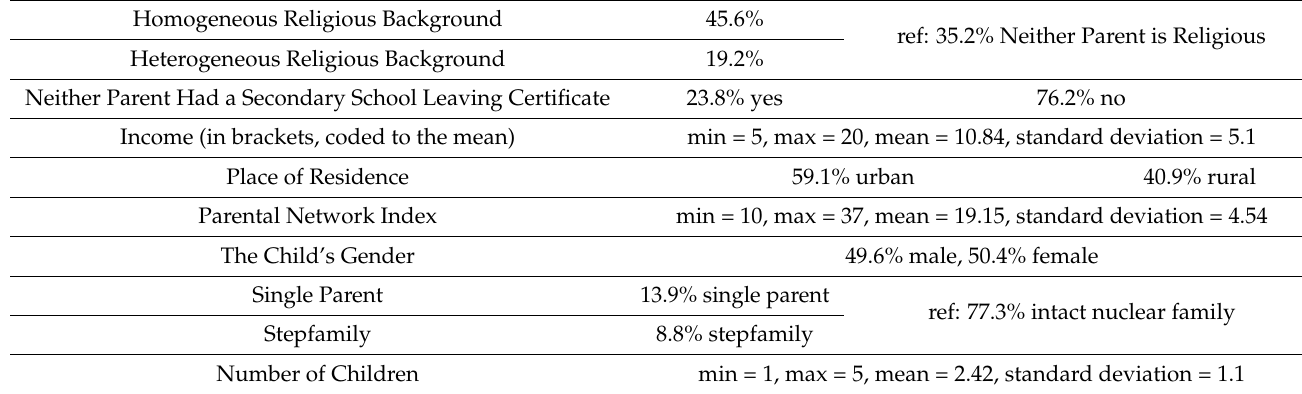
Table A2. Descriptive statistics of the explanatory